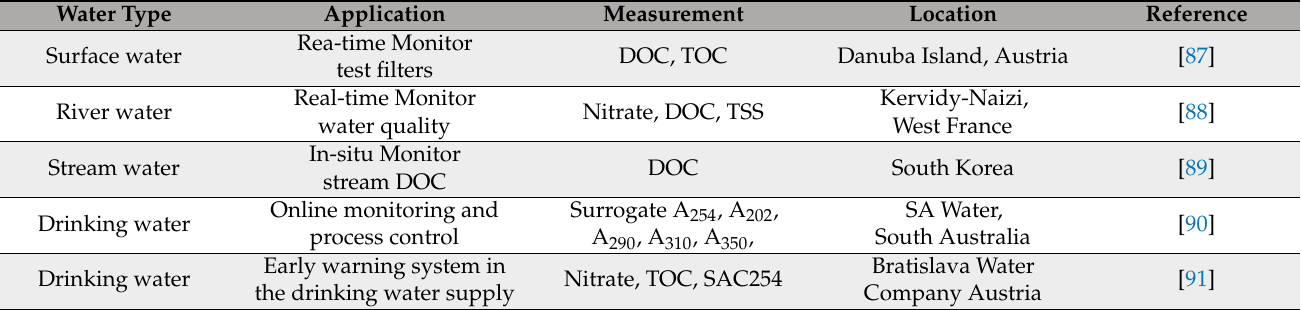
Table 3. Summary of field applications of online UV-Vis